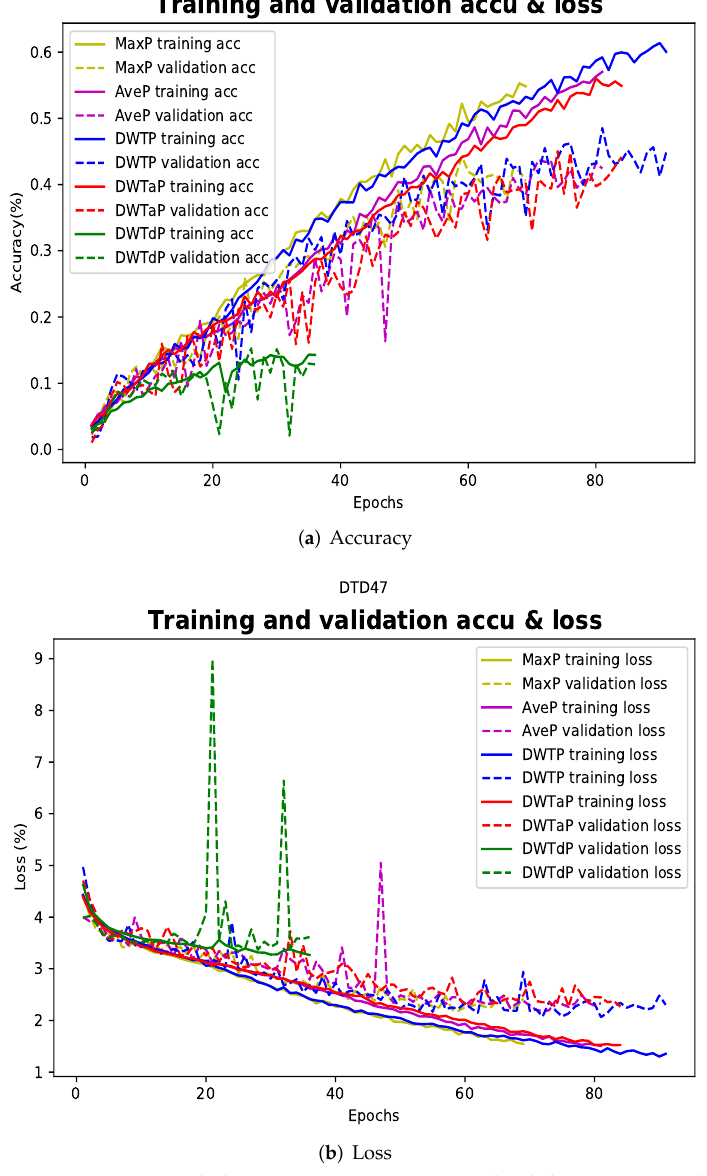
Figure 4. Learning behavior on DTD training and validation sets—Adam